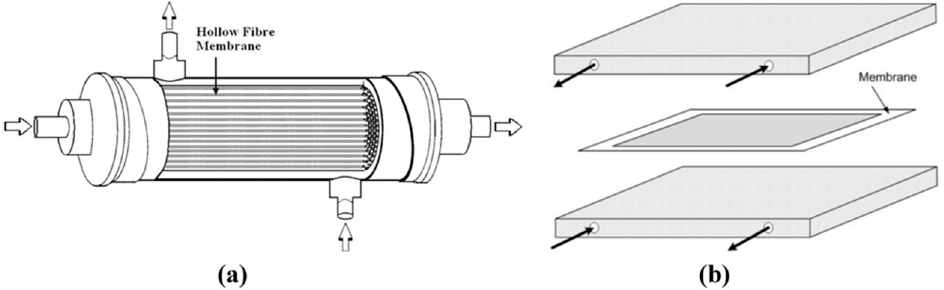
Figure 2. Membrane distillation modules: ( a ) Tubular module for hollow fiber; ( b ) Plate and frame module for flat sheet membrane. Open access. Reprinted from ref. [52] (Open access).